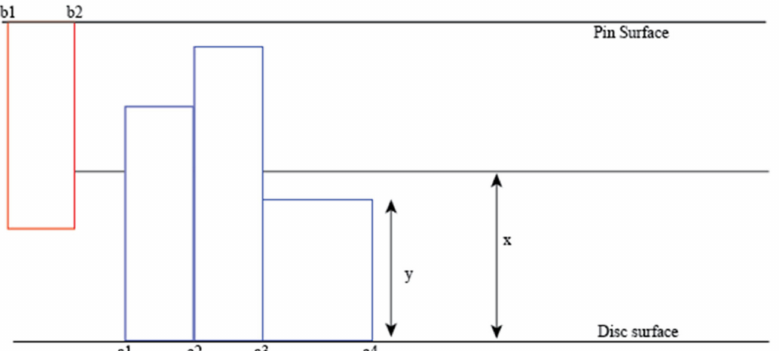
Figure 1. Conditions of contacts. a n and b n are points on the disc surface and pin surface, respectively. y is the height of asperity ( µ m) and x is the distance between the surface and the centreline ( µ m), which is defined as the mid-point between the two surfaces. Reproduced from Ref.